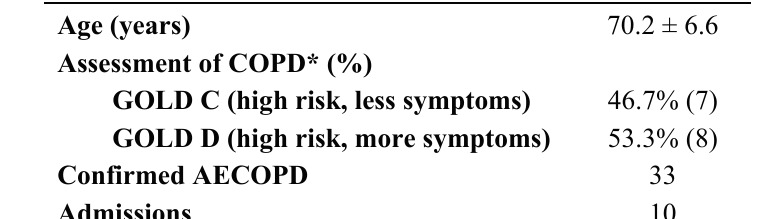
Figure 5. Flowchart with detailed information on patient participation, dropout and exacerbations along the pilot study. Table 2. Demographic and clinical characteristics of the participants that completed the trial ( N =